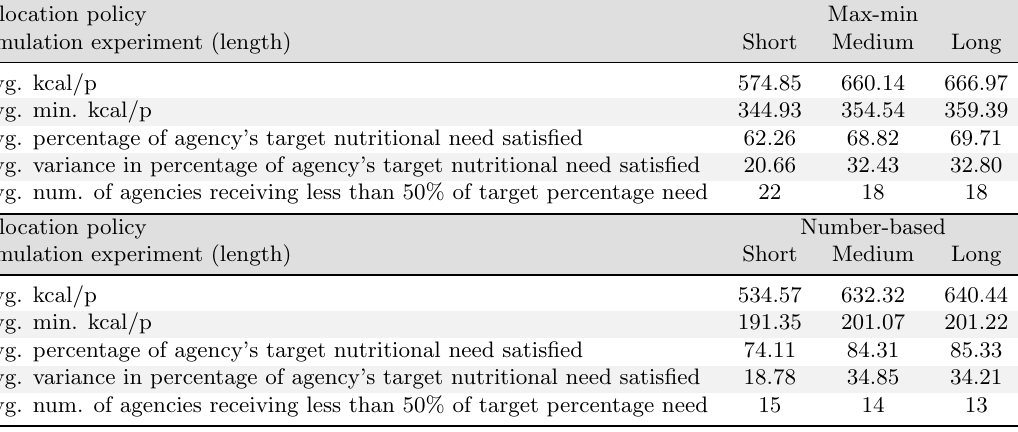
Table 2: Results from the three simulation